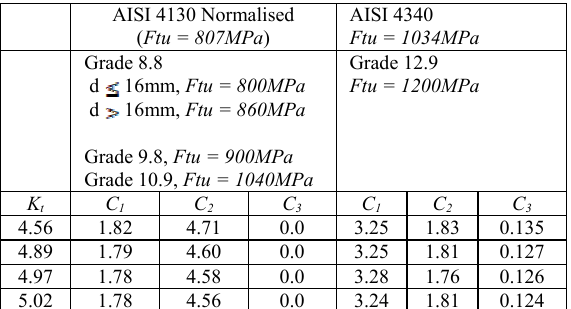
Table 4. Summary of elastic stress concentration factors.